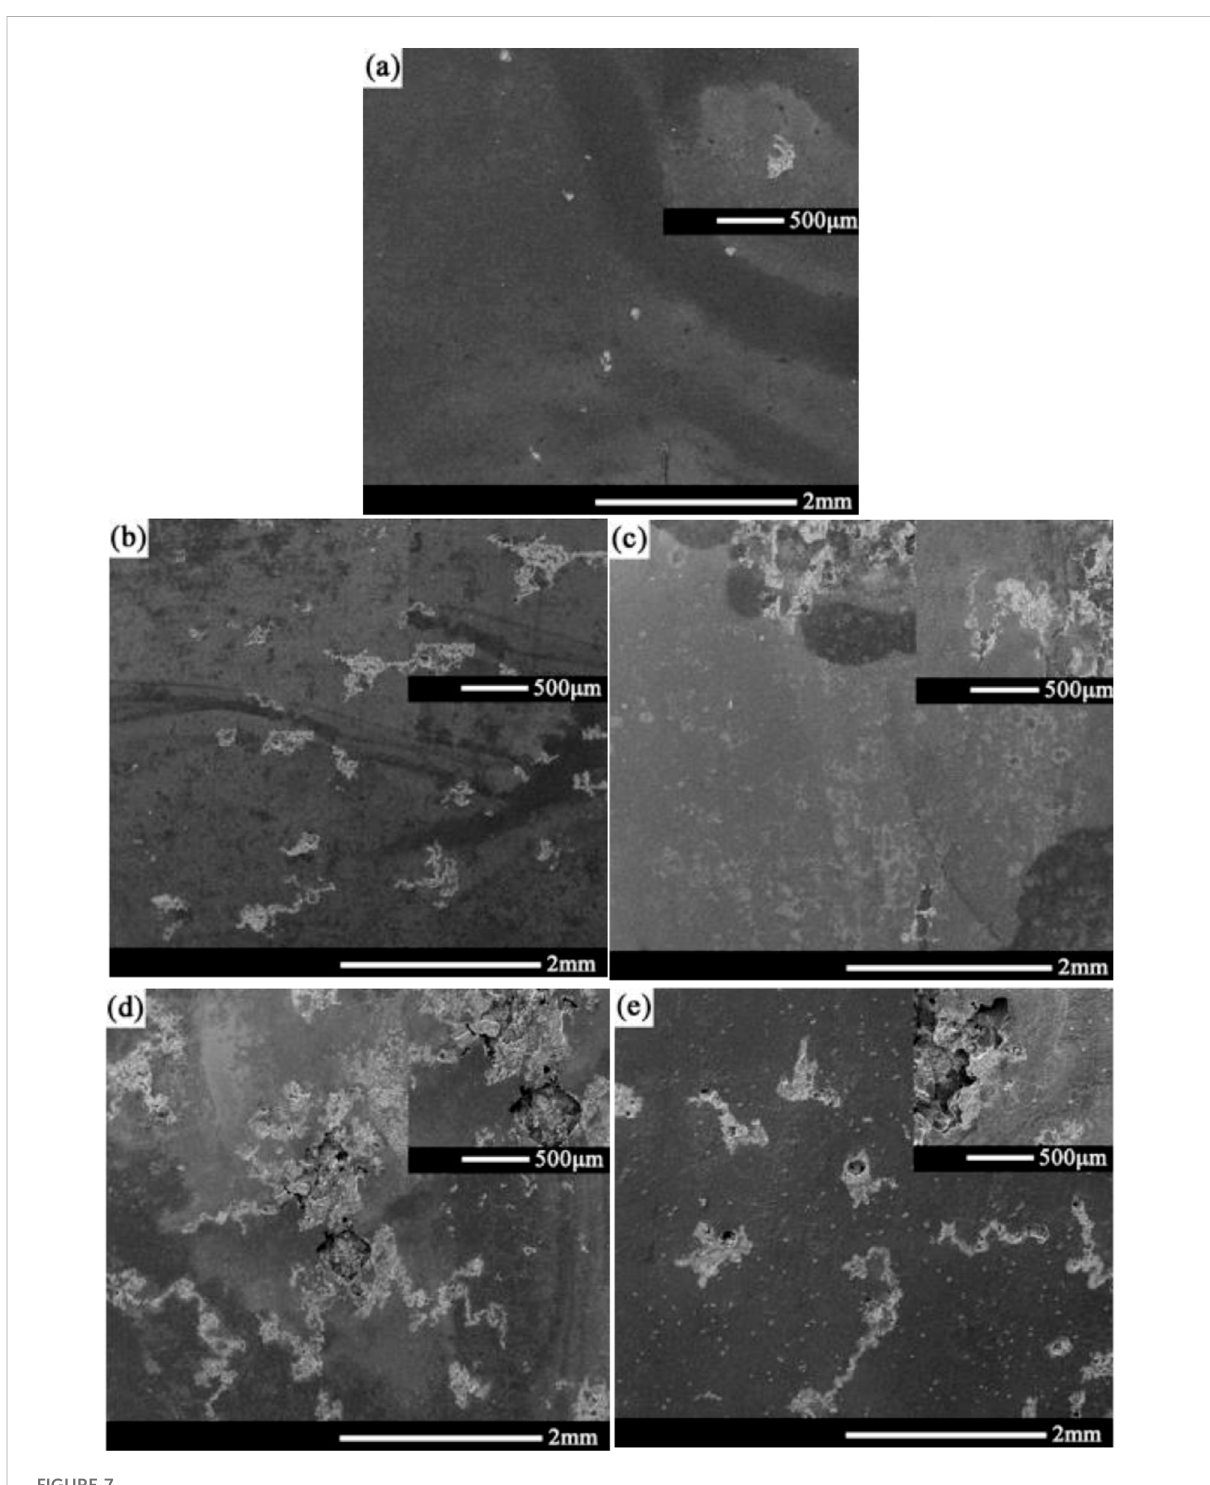
FIGURE 7 Corrosion morphology of 2060-T6 Al-Li alloy with different immersion time after removing corrosion products, (A) 6 h, (B) 24 h, (C) 72 h, (D) 168 h, (E) 720 h.